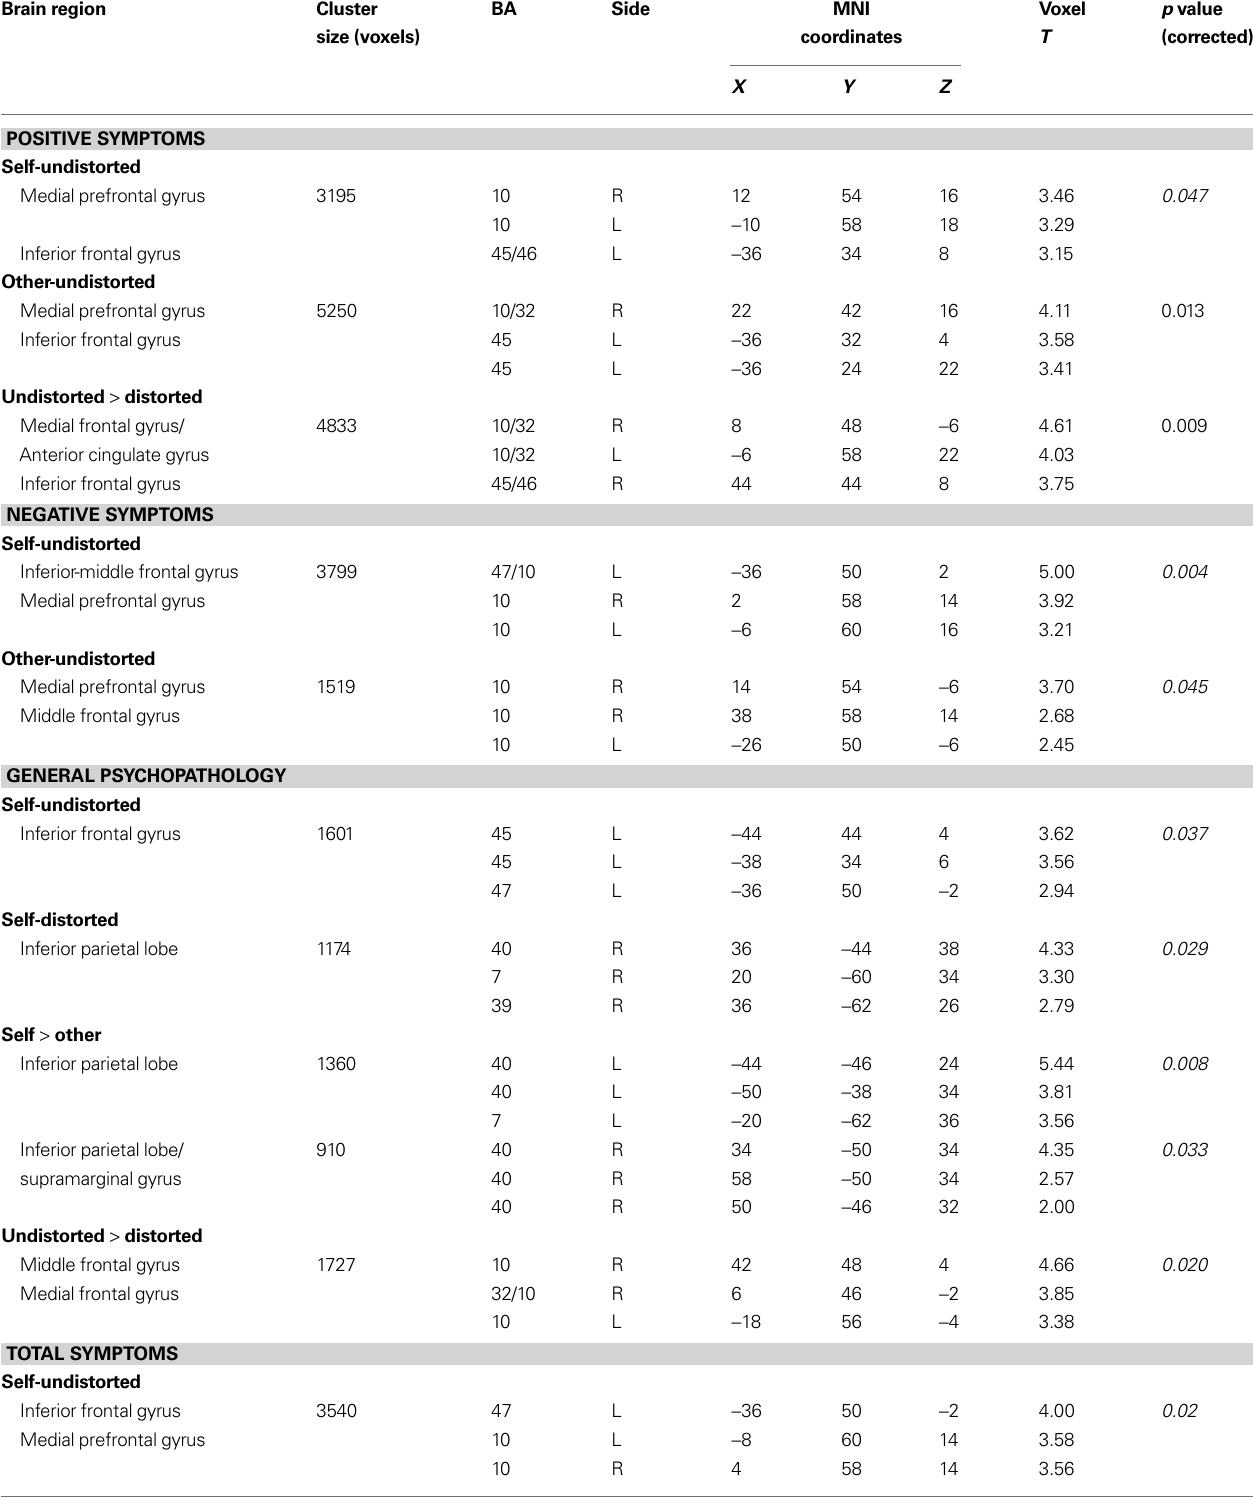
Table 4 | fMRI activity showing positive associations with CBTp responsiveness in patients (voxel threshold p = 0.05). Brain region Cluster BA Side MNI Voxel p value size (voxels)